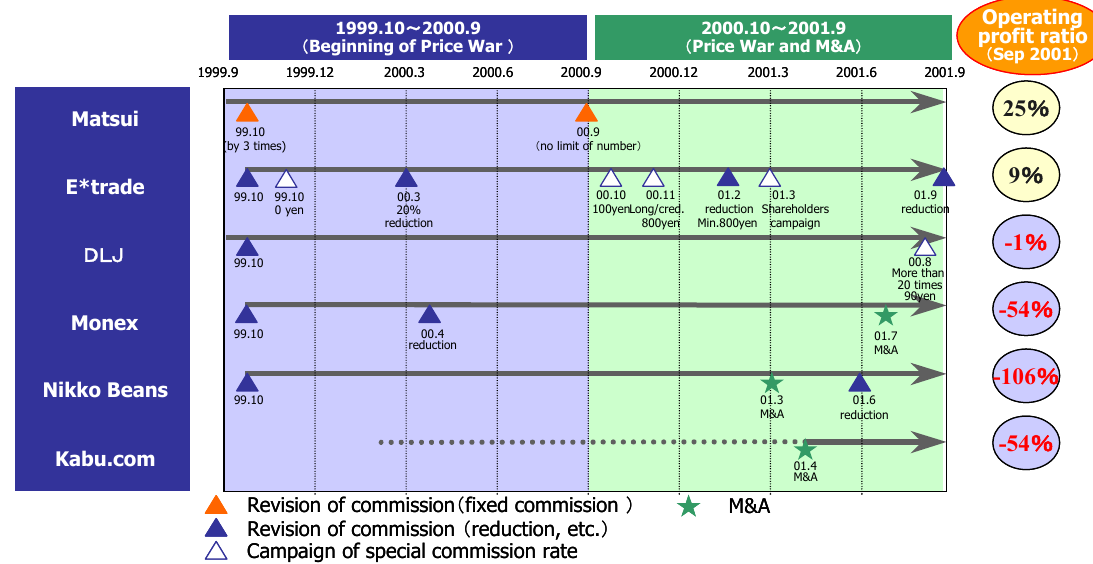
Figure 4. The Strategy for Increasing Number of